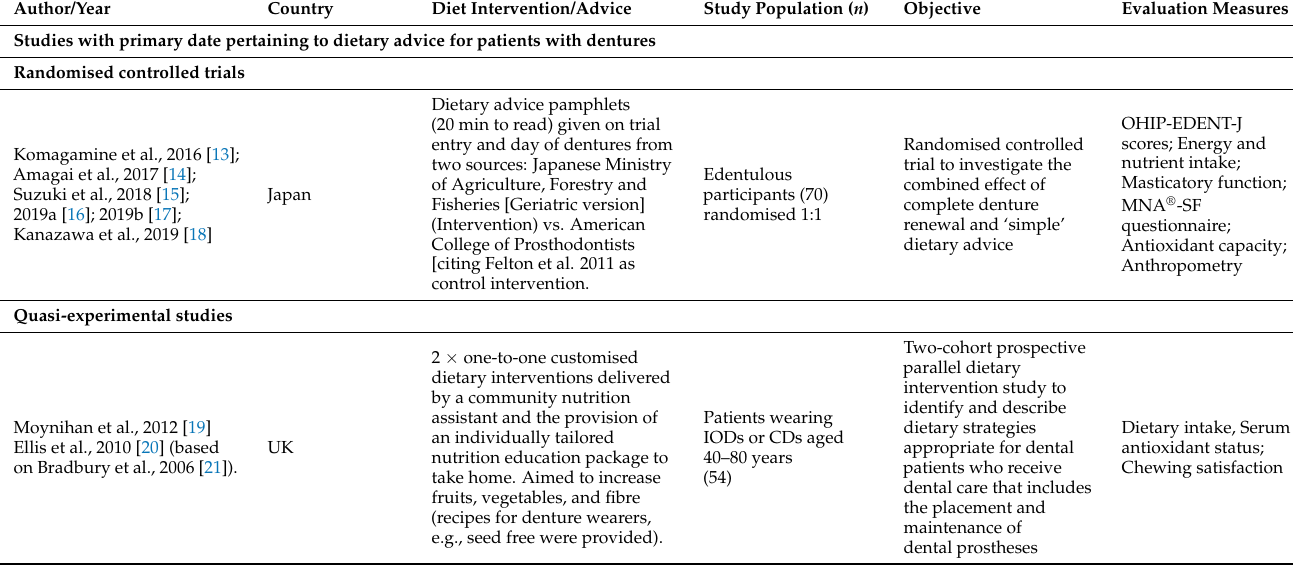
Table 1. Peer-reviewed papers with data and content relevant to the